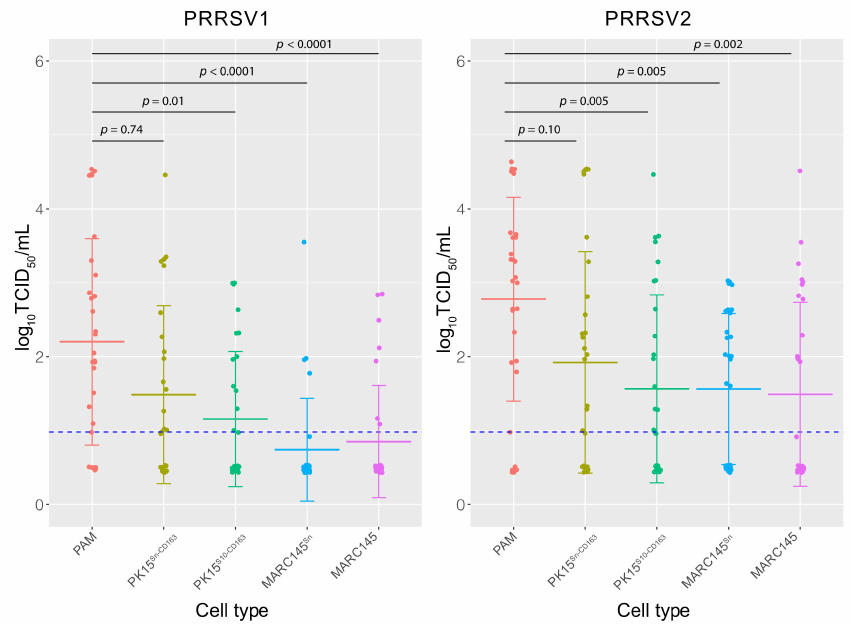
Figure 1. Comparison of virus titers obtained with the five different cell types. Virus titers obtained with each cell line were labeled with different colors. Data are given by dot plot including the mean value of the titers obtained from all the tested samples. The detection limit (0.96 log 10 TCID 50 ) was indicated with the blue dashed line. Differences were considered significantly different at p <